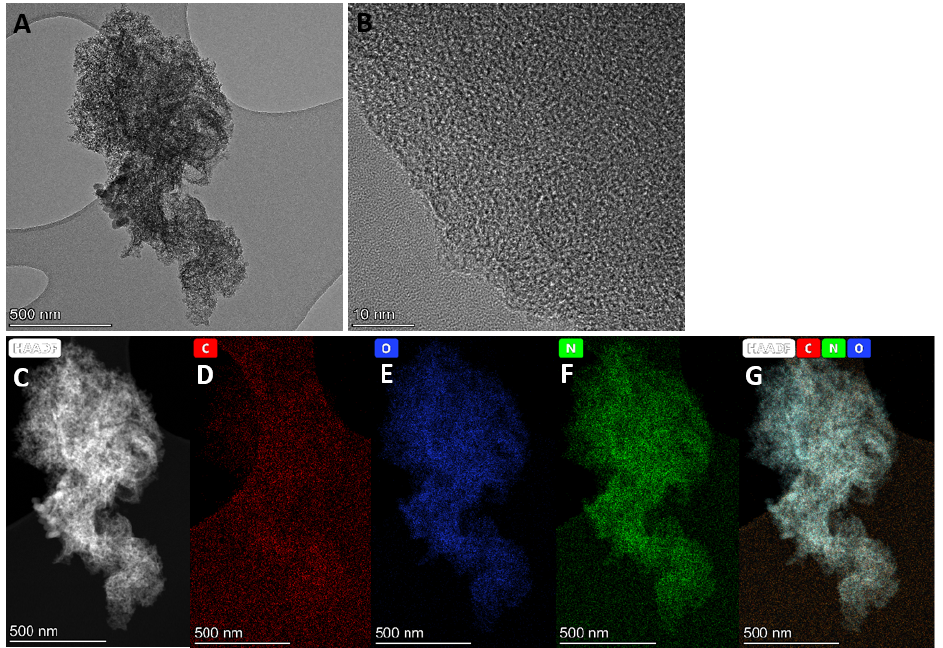
Figure 3. ( A ) Low-resolution and ( B ) high-resolution TEM images, ( C ) high-angle annular dark-field (HAADF) scanning transmission electron microscopy (STEM) image, and ( D – G ) energy-dispersive X-ray spectroscopy (EDS) elemental mapping of KAC urea .